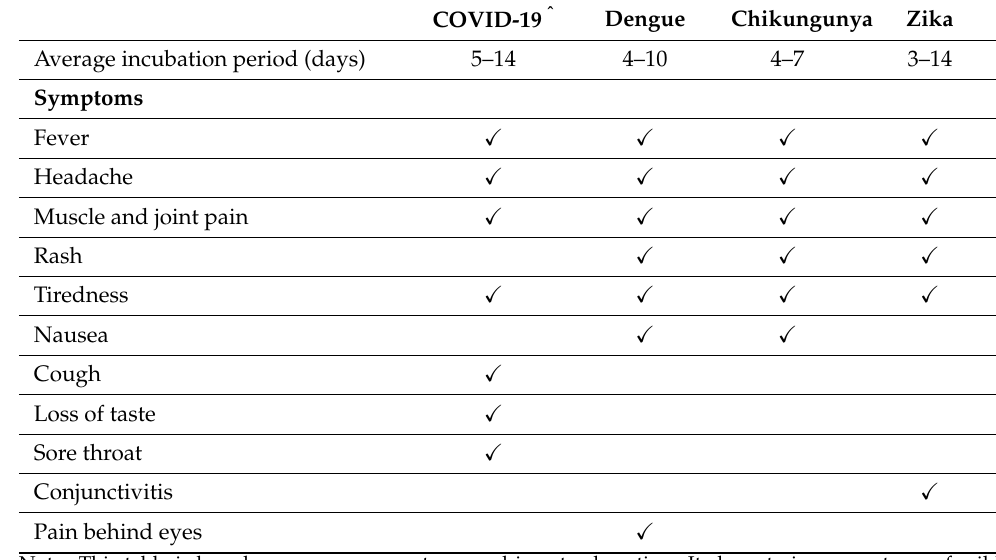
Table 2. Common symptoms of mild cases of COVID-19, DENV, CHIKV, and